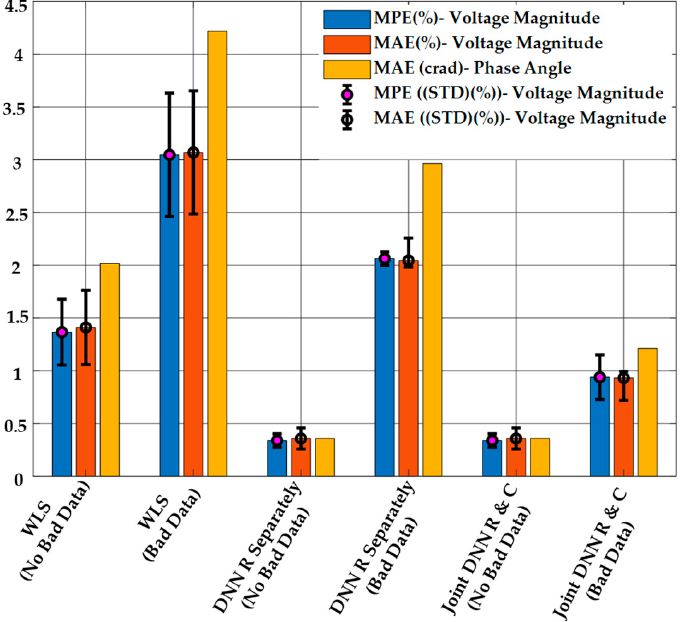
Figure 6. DSSE Results Obtained Using the Proposed Method, the Regression-only DNN Model, and WLS with or without Bad Data when N a = 1200 ( 10% ) , and z a = { ( 1 ± 0.05 ) z , ( 1 ± 0.1 ) z } .